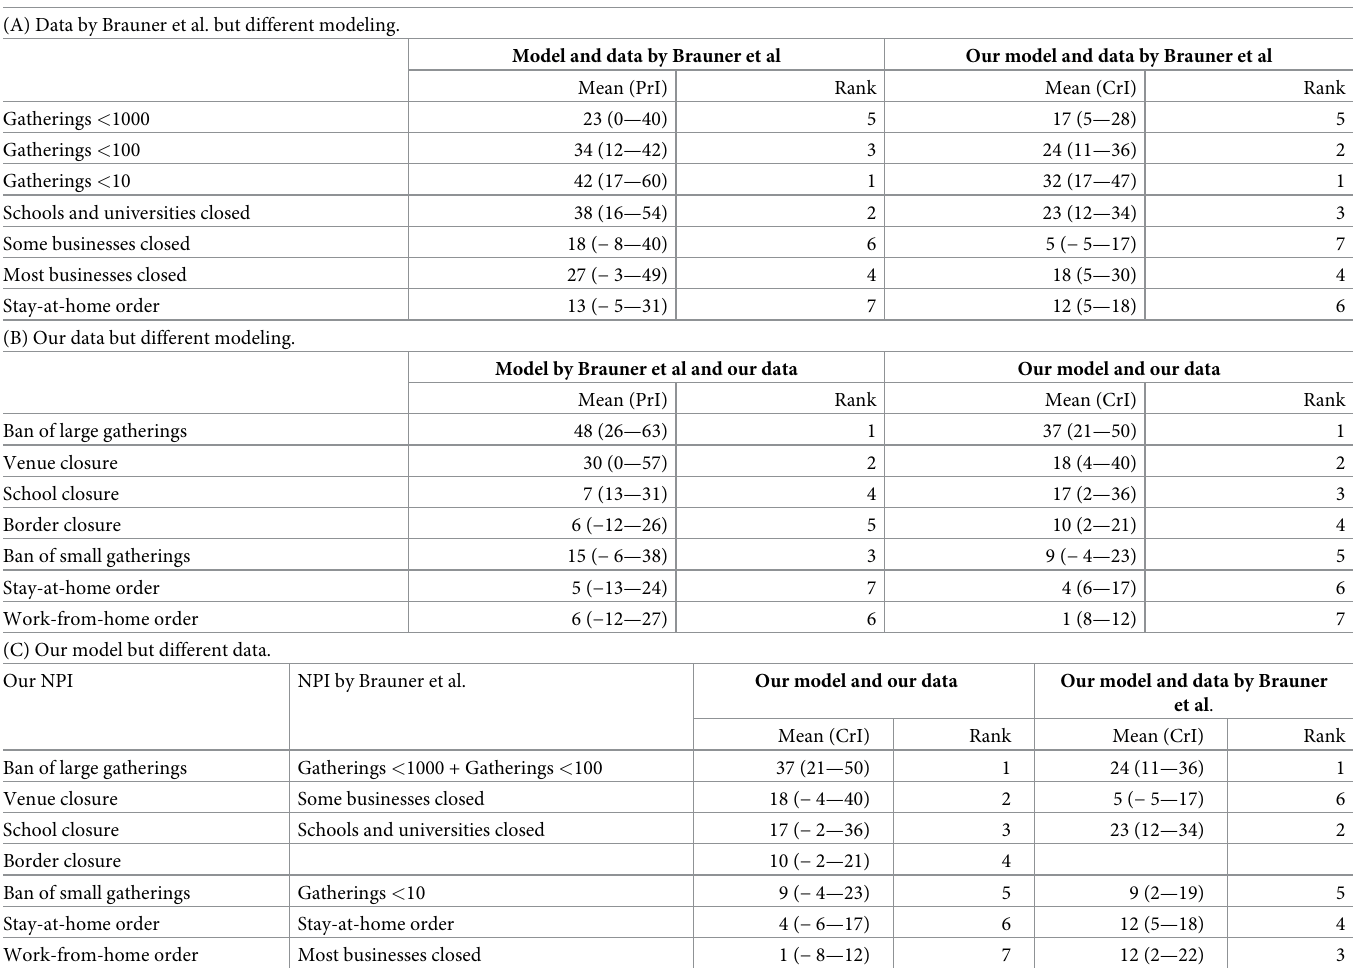
Table 2. Comparison of modeling and data with results from Brauner et al. [11]. (A) Estimated effects by model and data from Brauner et al. (posterior mean in%, 95% prediction interval (PrI) and rank) and by our model and data from Brauner et al. (posterior mean in%, 95% credible interval and rank). Note that, in these analyses, we report cumulative effects for bans of small gatherings and businesses closed as in Brauner et al. (B) Estimated effects on our data by the model from Brauner et al. (posterior mean in%, 95% prediction interval (PrI) and rank) and by our model (posterior mean in%, 95% credible interval, and rank). (C) Estimated effects by our model on our data (posterior mean in%, 95% credible interval, and rank) and by our model and data from Brauner et al. (posterior mean in%, 95% credible interval, and rank). Similar NPIs were matched but their definitions are not exactly the same. Note that in applying our model to the data by Brauner at al., we report the cumulative effect of “Gather- ings < 1000” and “Gatherings < 100” when referring to our ban of small